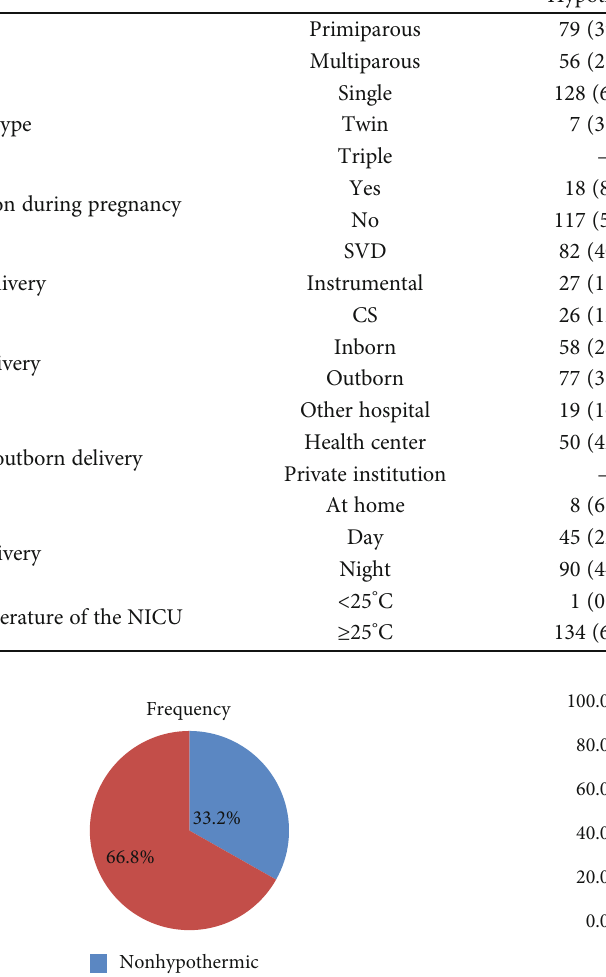
Table 3: Obstetric and environmental factors of the study participants in Dessie Referral Hospital, Northeast Ethiopia, 2018 ( N = 202 ). Variables